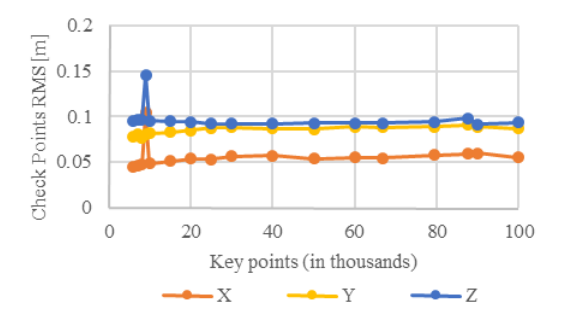
Figure 3. RMS of errors (in meters) achieved on Check Points in Pix4D (Katowice dataset) with different number of key points